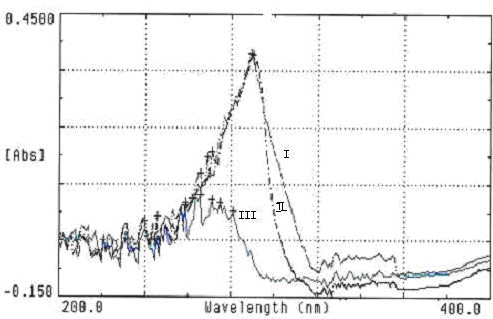
UV spectra of 5-FU/PEG-PBLG nanoparticles. I: 5-FU; II: 5-FU + PEG-PBLG nanoparticles; III: 5-FU/PEG-PBLG nanoparticles. I and II had high absorbance at 269 nm while the absorbance of III was much lower at 269 nm.